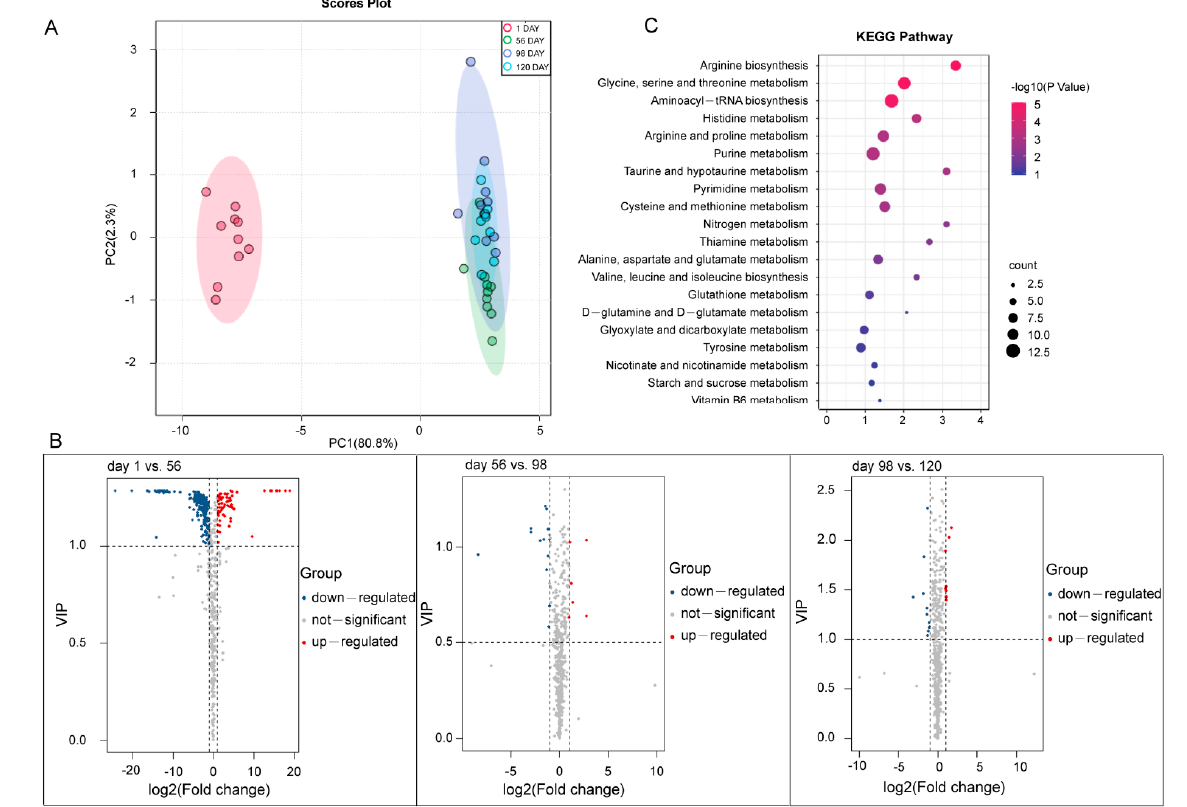
Figure 3. Analysis of metabolites of breast muscle at four developmental stages of Beijing-You chicken (BJY). ( A ) Principal component analysis (PCA) of the identified metabolites. The X axis represents PC1 and the Y axis represents PC2. Each sample had ten biological replicates. ( B ) Significantly changed metabolites (SCMs) between different stages. ( C ) The top 25 significant terms of SCMs by KEGG analysis.